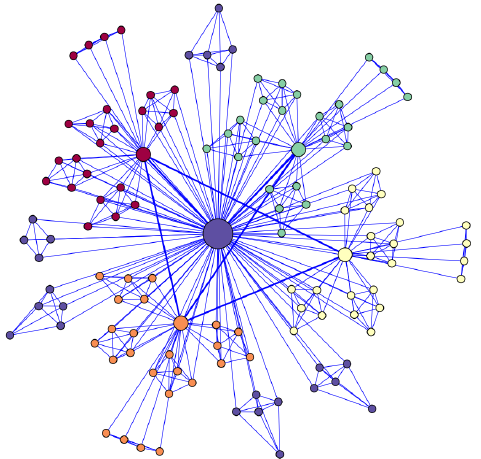
Figure 1. Schematic representation of Ravasz-Barabási network at step 2, rich-club organization and κ = 0.5. Each node represents a neuron. The size of the nodes indicates the degree, the color of the nodes indicates the five different clusters. The most connected node (global hub) is shown at the center of the graph. Four local hubs are also shown. Eight network replicas are used to form a network with 1000